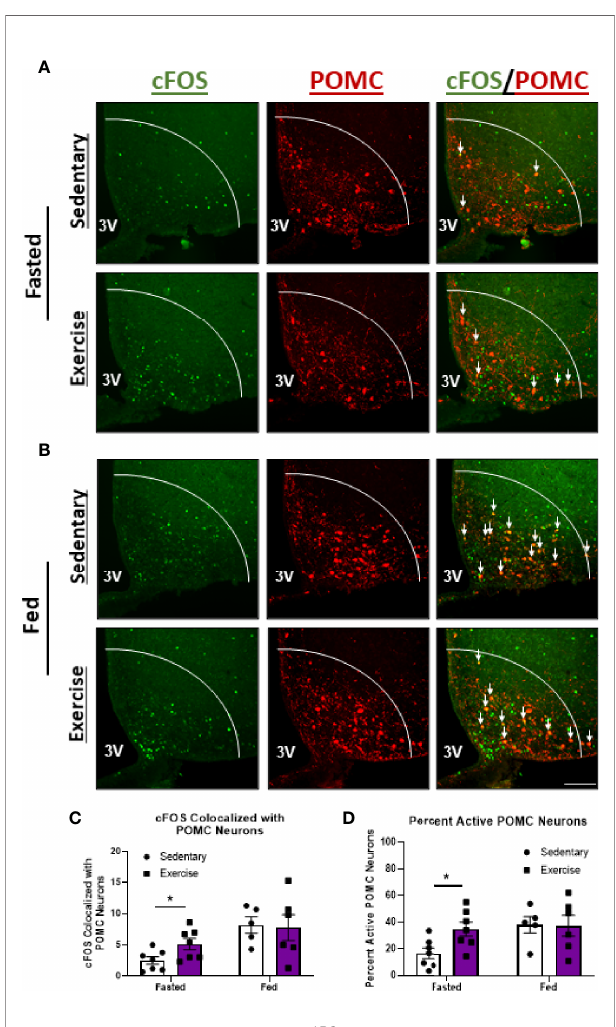
FIGURE 6 | Exercise-mediated POMC ARC activation is speci fi c to the fasted status. Representative images of cFOS (green) colocalized with POMC ARC neurons (red) in (A) fasted or (B) fed male mice 1 hour after sedentary trials or high intensity treadmill exercise. (C) cFOS-expressing POMC ARC neurons and (D) Percent active POMC ARC neurons (n = 5-7/group). 3V = Third ventricle; Scale bar = 50um. Data represented as mean ± SEM. *indicates p < 0.05 vs. sedentary